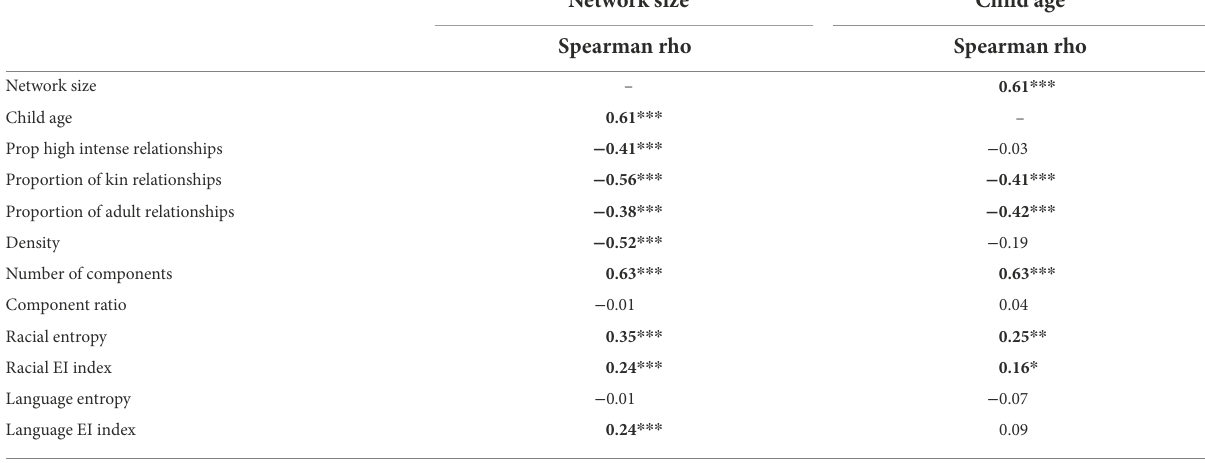
TABLE 2 Table of correlations between network size, age, and other network